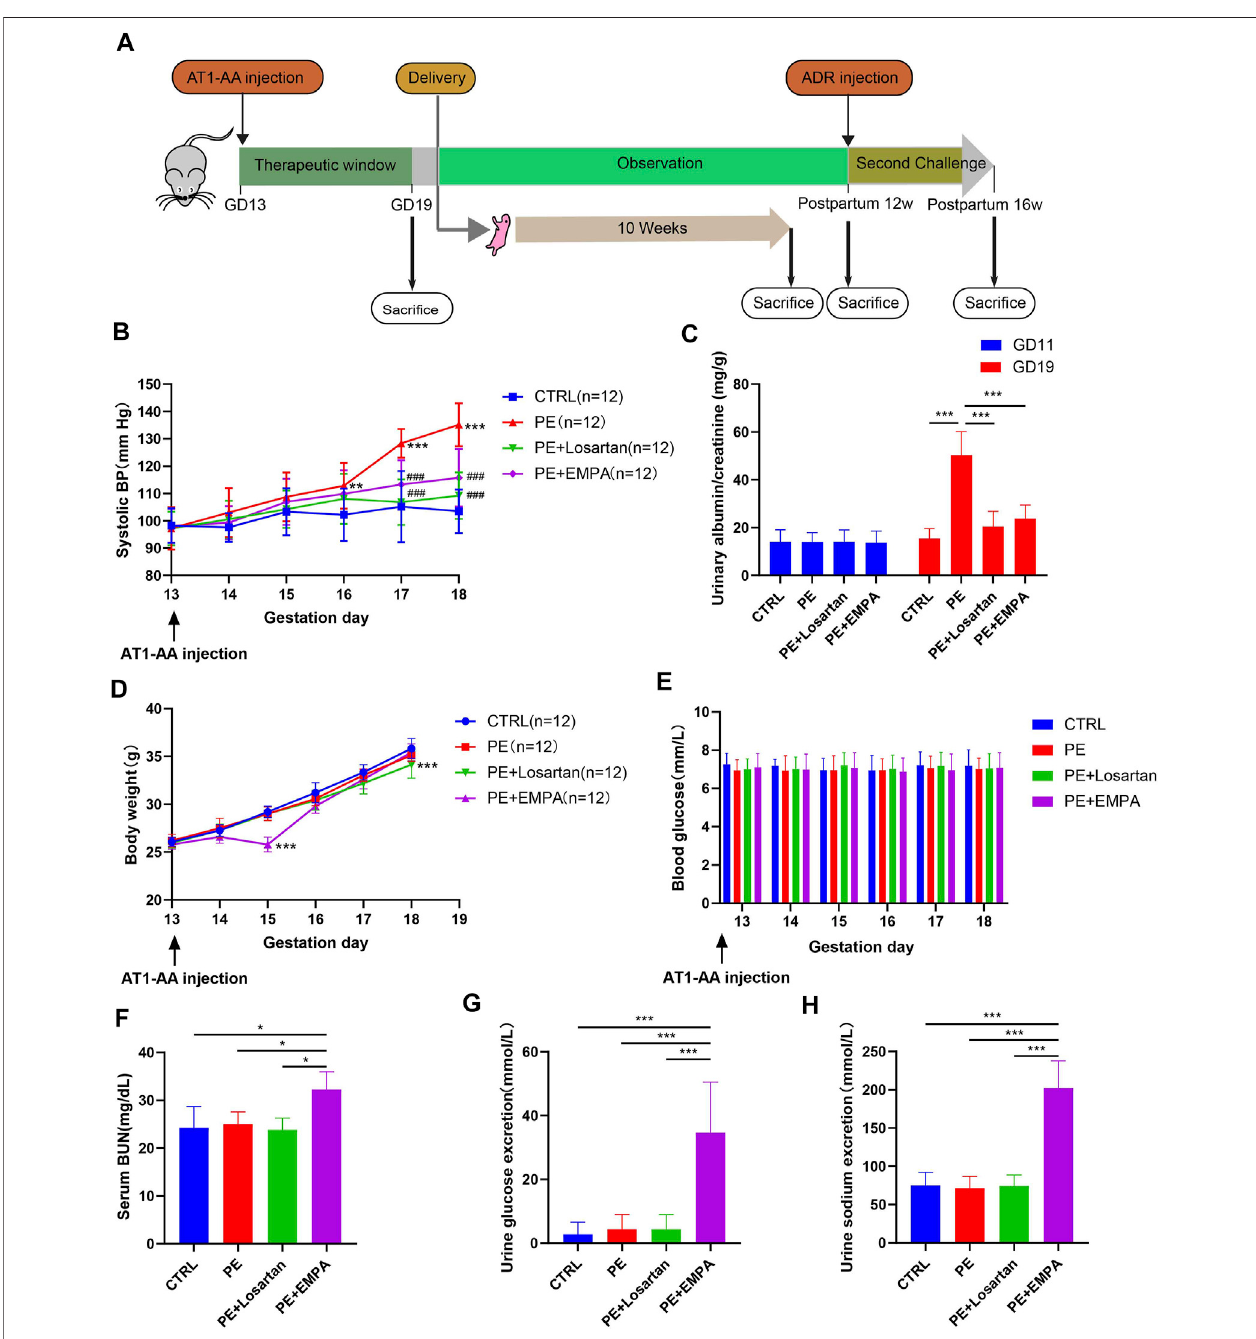
FIGURE 1 | EMPA reduced SBP and ACR and induced glycosuria and natriuresis in an AT1-AA-infused mouse model. (A) Schematic illustration of animal experiments. (B) Systolic blood pressure (SBP) recorded from GD13 to GD18 of control or PE mice treated with EMPA or losartan ( n = 12). (C) Urinary albumin to creatinineratio(ACR) onGD11andGD19incontrolandPEmice( n =12). (D,E) MousebodyweightandbloodglucoserecordedfromGD13toGD18ineachgroup( n = 12). Mouse serum BUN (F) ( n = 3), urine glucose excretion (G) ( n = 12) and urine sodium excretion (H) ( n = 12) of each group. Data are expressed as the mean ± SEM and were analyzed by ANOVA with LSD post hoc test. * p < 0.05, ** p < 0.01, *** p < 0.001.